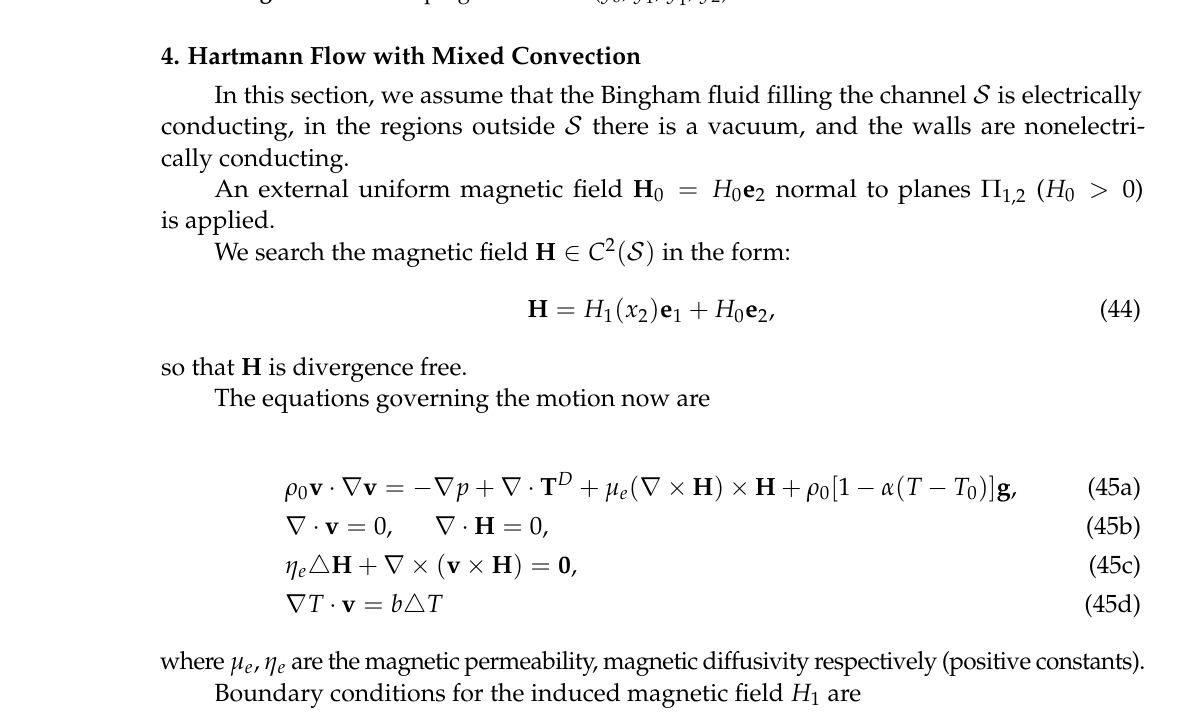
Figure 11. Case 3 : plug boundaries ( y 0 , y 1 , y